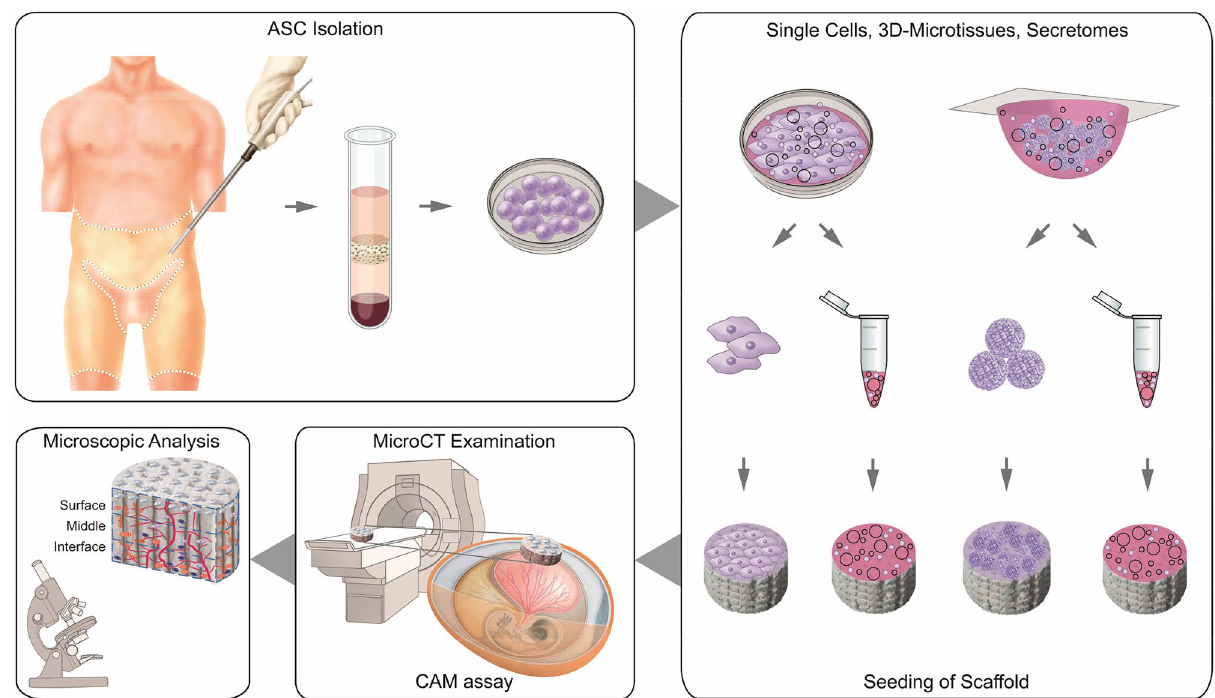
Figure 7. Schematic experimental setup for the investigation of calcification capacity of Optimaix scaffold in combination with human adipose tissue-derived mesenchymal stem cells or secretome . After isolation of human ASCs, the cells are cultured either as 2D -single cells or as 3D-microtissues. Afterwards, they are seeded onto collagen scaffolds. The secretomes of both cell formats are also added to separate scaffolds. After incubation of the scaffolds on the CAM, microCT analysis is performed to determine the degree of calcification and followed by a comprehensive histological Vessels in the 2D-SC secretome group, however, were newly formed predominantly in the middle region and were significantly different compared to 2D-SCs only. Considering these findings, its secretome was just as potent as the cell-based cultivation itself. These can be explained by the paracrine factors influencing neovascularization to a high degree 65,66 . Glycosaminoglycans (GAGs) have become a powerful tool in TE the last years and drew attention for the crea- tion of new biomaterials 67–69 . They provide biocompatible, biodegradable and non-immunogenic properties that